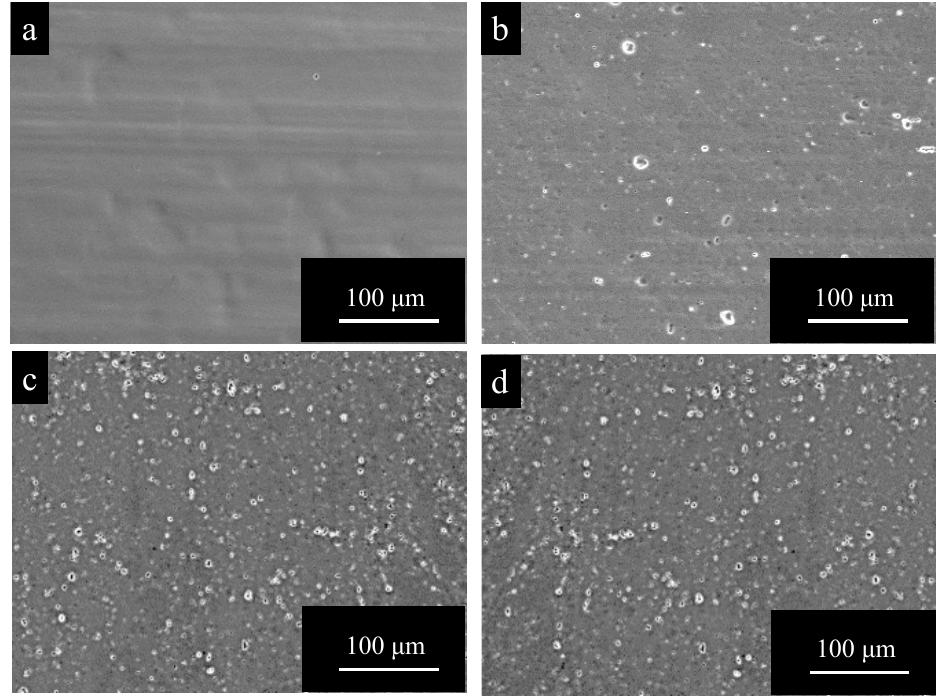
Figure 3. Anode potential transients ( E a vs. t a ) during anodizing of pure Al, 1050-, 3003- and 5052- Al alloys with a constant c.d. of 200 Am − 2 in 2 wt% -(COOH) 2 solution at 313 K.